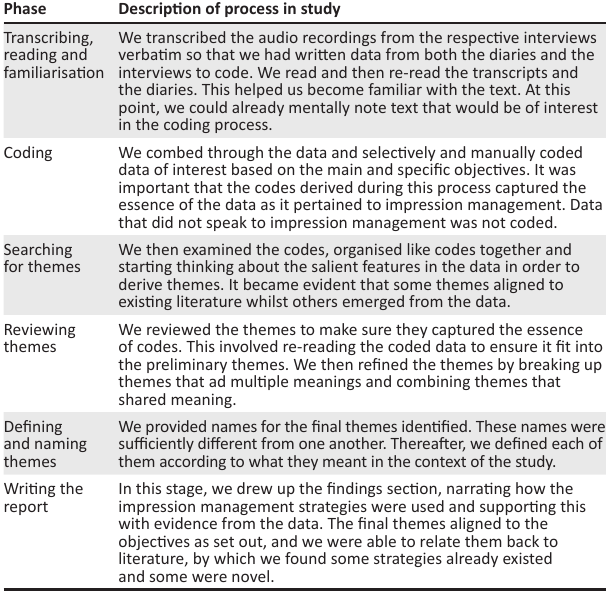
TABLE 3: Thematic analysis of data. Phase Description of process in